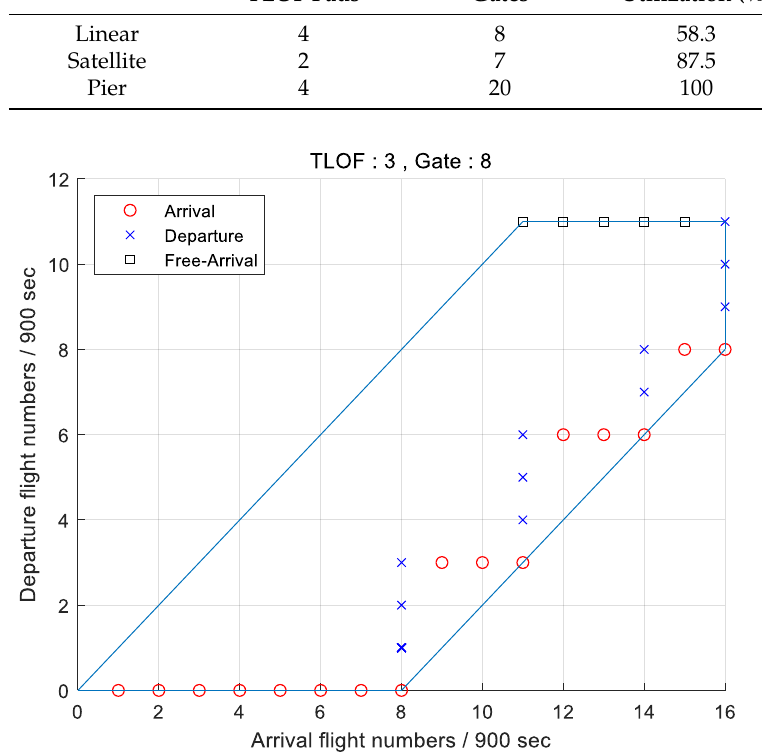
Figure 33. Capacity of a linear topology for Gimpo Airport’s expanded parking lot space that complies with the FAA’s new regulations.